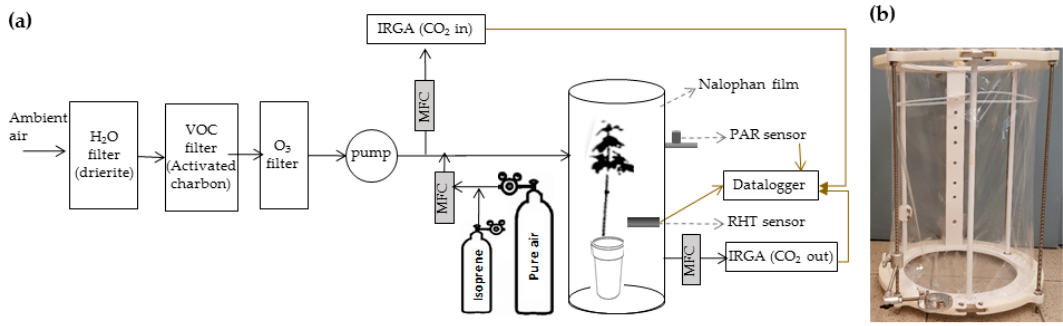
Figure 5. ( a ) Scheme of the system used during fumigation of a maple sapling. Continuous, discontinuous and brown arrows denote the flow direction, the name of the instrument and electronic connections respectively. MFC: Mass flow controller. ( b ) Picture of the enclosure chamber built with a PTFE-made structure and external stainless-steel bars (grey) for chamber fixation.